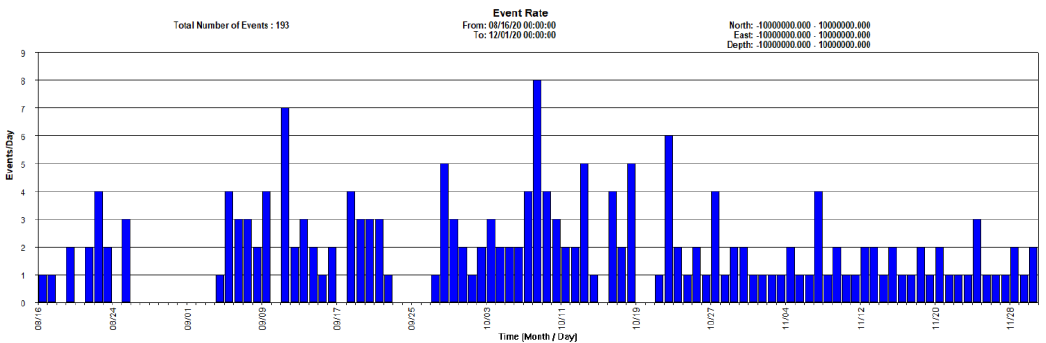
Figure 6. Temporal evolution of daily MS events.